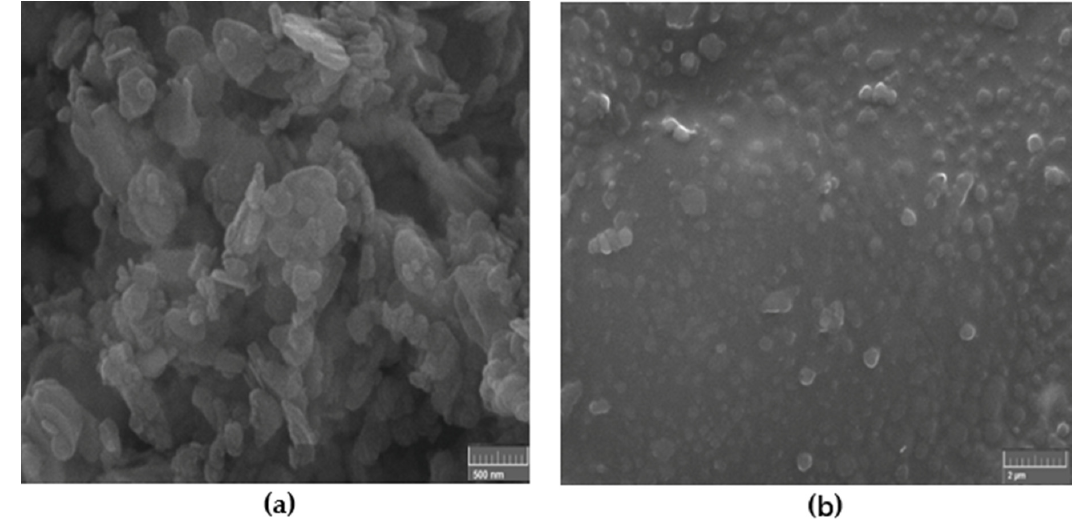
Figure 3. SEM image of: ( a ) high ‐ resolution h ‐ BN nanoparticles 50–70 nm which were used as reinforcement fillers and ( b ) nanocomposite reinforced with 0.5 wt.% of such nanoparticles under ultrasonic mixing.